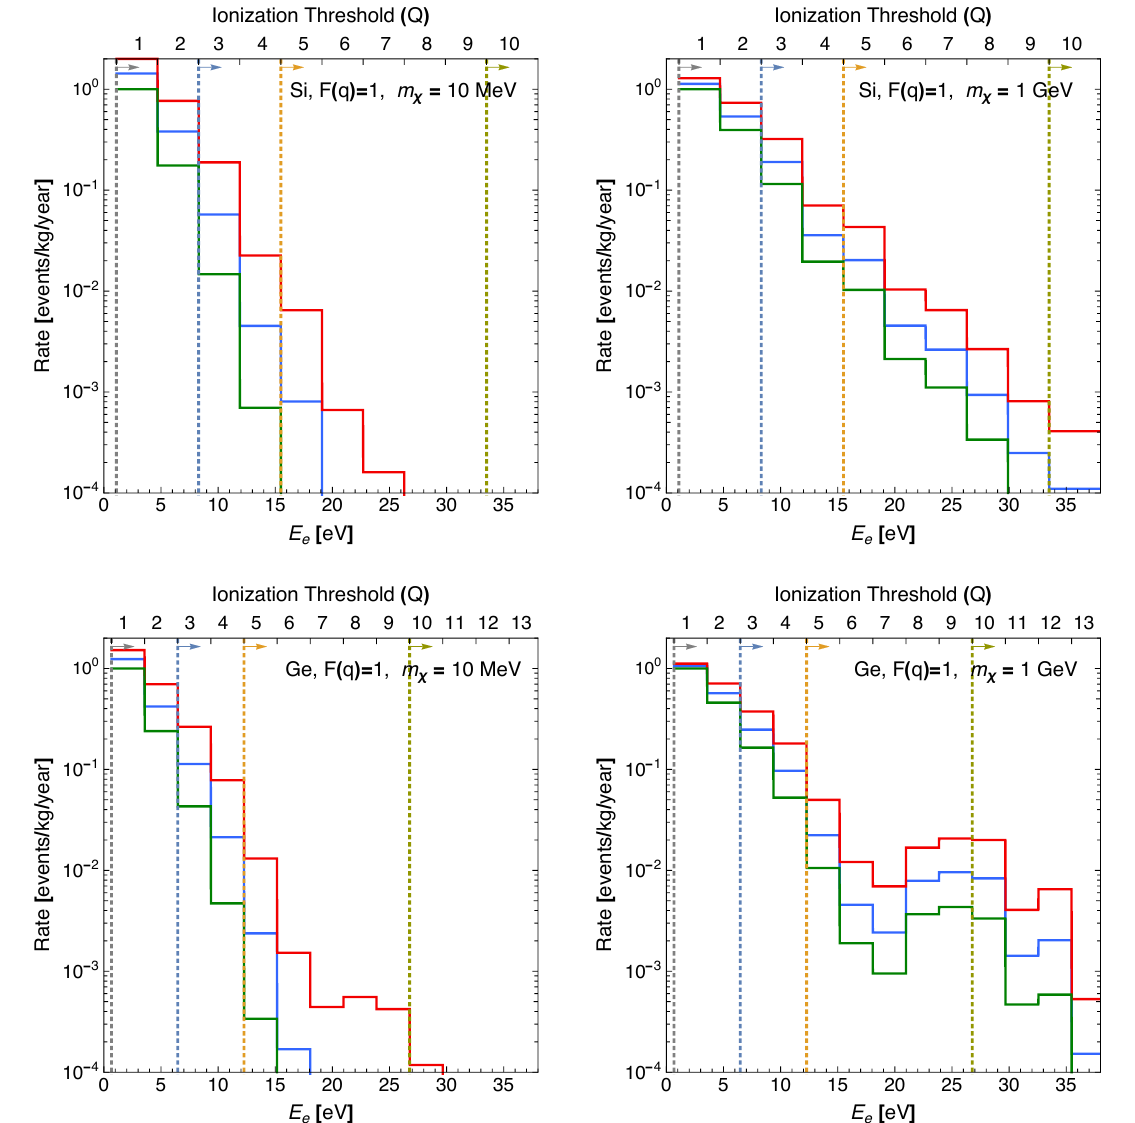
Figure 2 . Normalized event rate vs. electron energy and ionization threshold (number of electron- hole pairs). The top panels show germanium target, while the bottom ones silicon target, whereas the left ones are for m (cid:31) =10 MeV and the right ones for m (cid:31) =1 GeV. The color coding is as in (cid:12)gure 1, corresponding to the central MED (blue), MAX (red) and MIN (green) velocity pro(cid:12)les. All events are normalized to the (cid:12)rst bin of the MED distribution. The vertical lines indicate the electron-hole pair ionization thresholds as will be shown below in (cid:12)gures 3 and 4; only electron energies to the right of a given line are su(cid:14)cient to produce a given number of